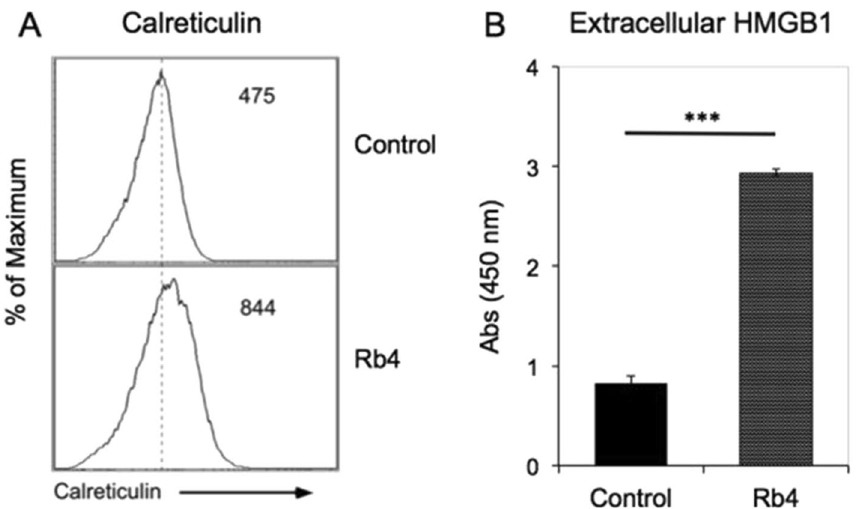
Figure 9. Expression of DAMPs by Rb4 treatment. B16F10-Nex2 cells were treated with 0.15 mM Rb4 for 16 h. ( A ) Calreticulin expression of control cells and treated cells was detected by flow cytometry. ( B )